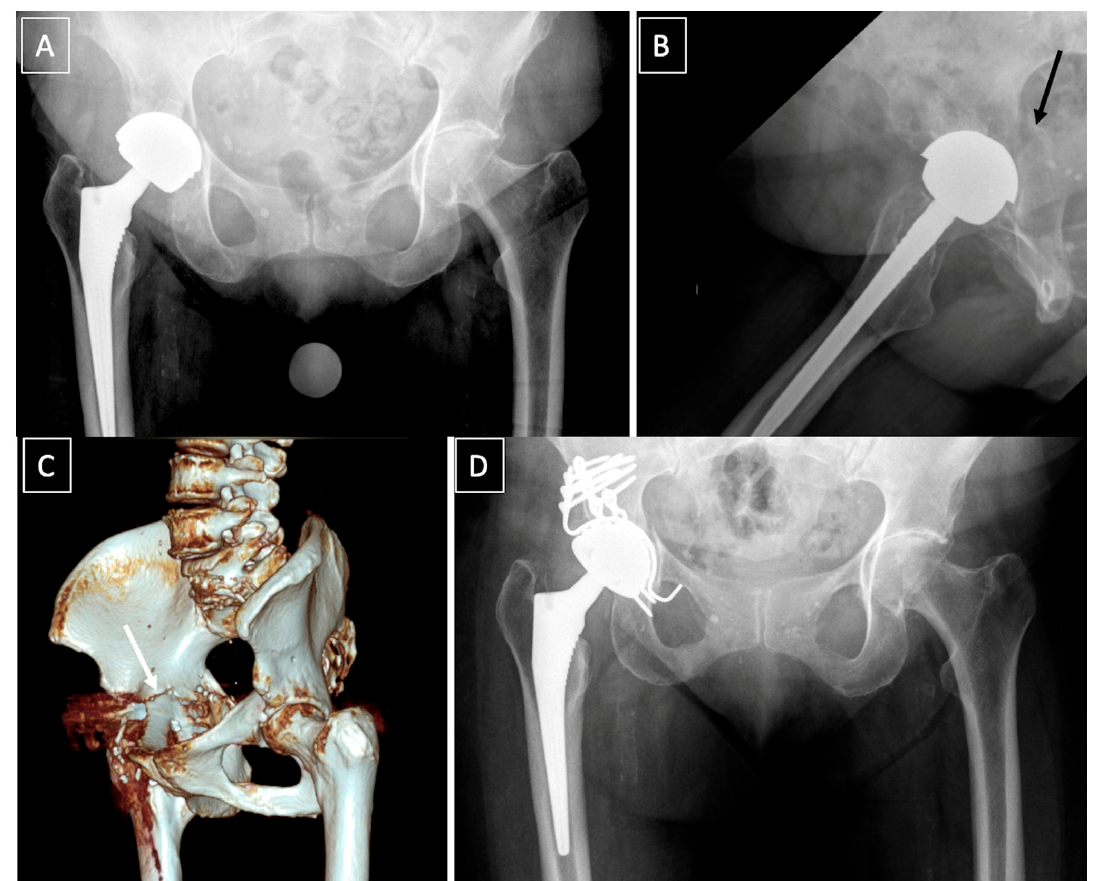
Figure 3. Failure of a conservative treatment of an acute post-operative fracture (black arrow) ( A , B ), following a low energy trauma, at 6 months. ( C ): 3D CT scan showing a nonunion of a transverse fracture of the acetabulum (white arrow). ( D ): postoperative X-ray showing a plating of the posterior column and reconstruction with a Kerboull acetabular device and a cemented dual-mobility cup. Reaming to activate nonunion was performed and bone graft added. Septic non-union was ruled out with intraoperative samples.